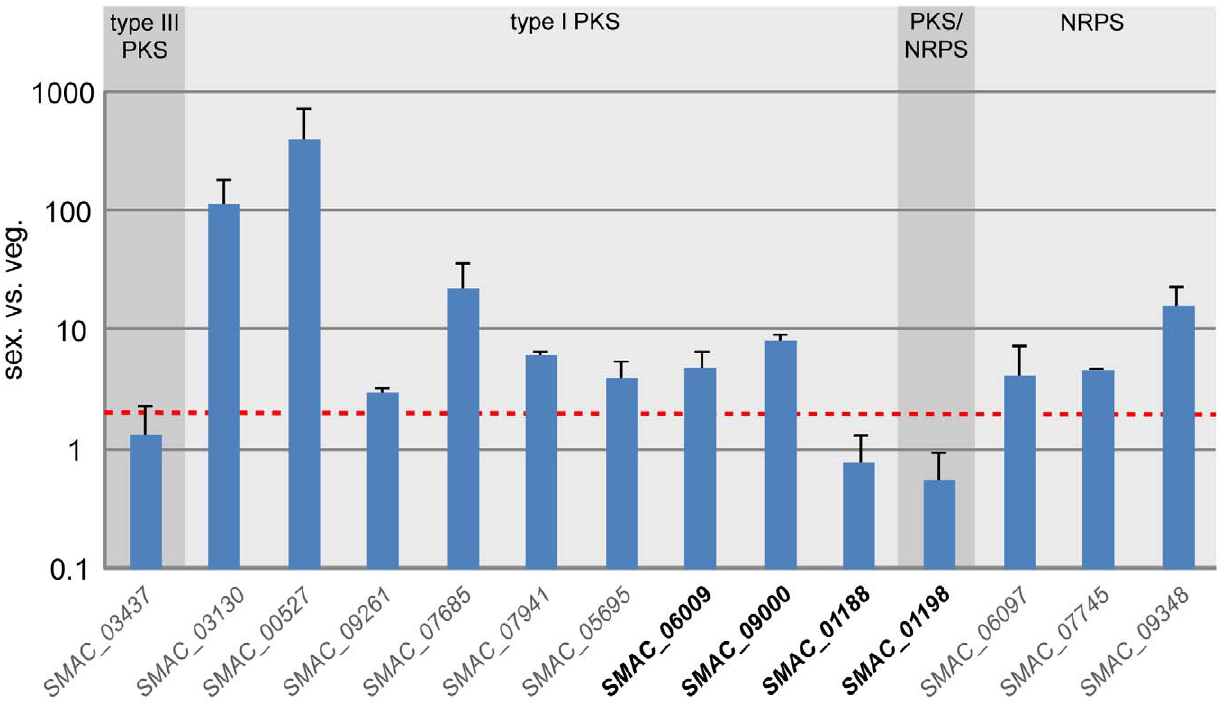
Figure 7. Expression of all predicted pks and nrps genes in S.macrospora during sexual development compared with vegetative growth. Gene names for which a N. crassa ortholog is present are given in gray, gene names where no N. crassa ortholog exists are given in bold black (see also Table S18). All expression data are the results of at least two independent experiments and were determined by quantitative real time PCR. Data for six of the genes (the first six type I pks genes, SMAC_03130 to SMAC_05695 ) were taken from previous studies [36,78], expression of the other eight genes was determined in the course of this investigation. The type of encoded protein (type I PKS, type III PKS, PKS/NRPS hybrid, and NRPS) is indicated. The red line indicates two-fold